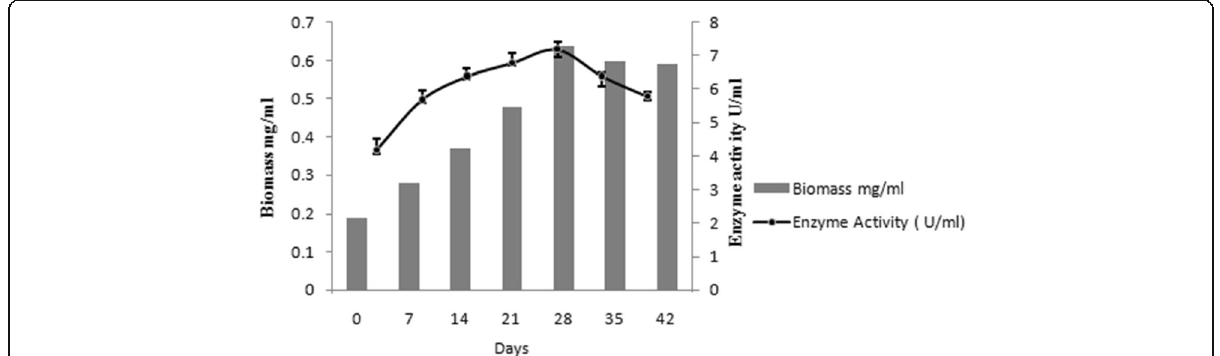
Fig. 1 Effect of protonemal growth on α -glucosidase production in H. nymaniana. Error bars represents mean ± standard deviation from five experimental data